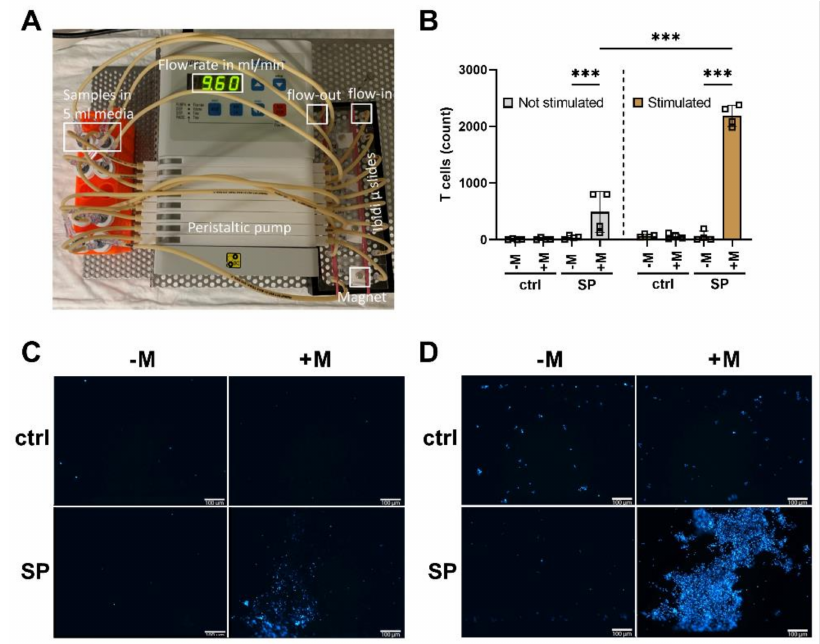
Figure 5. Dynamic magnetic enrichment of T cells. CD3+ T cells were isolated and stimulated